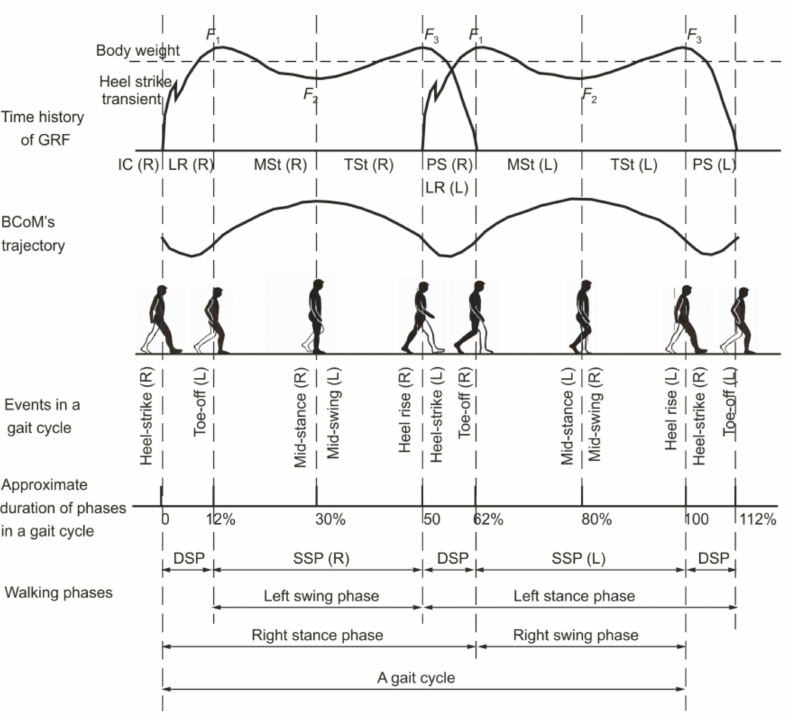
Figure 1. Ground reaction force, trajectory of body centre of mass, and key events in a gait cycle (adapted from